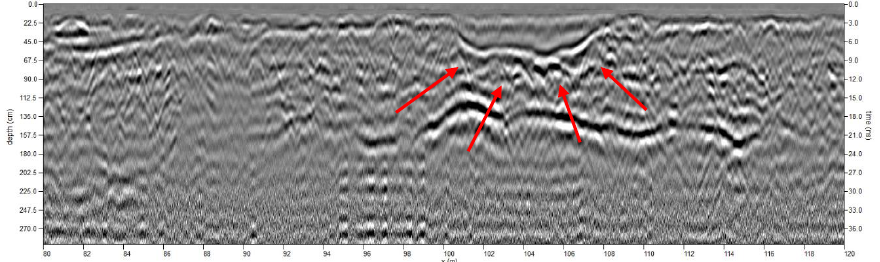
Figure 9 . GPR radargram showing the subsurface channel in vertical profile.